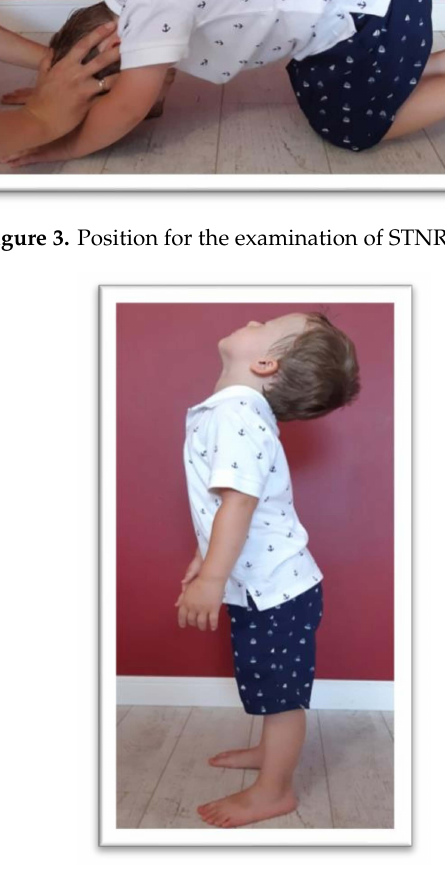
Figure 4. Position for the examination of tonic labyrinthine reflex (TLR) extension.